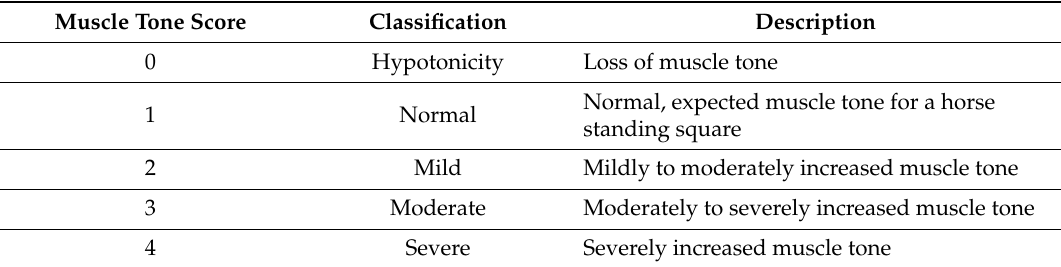
Table A1. Muscle tone scoring system.